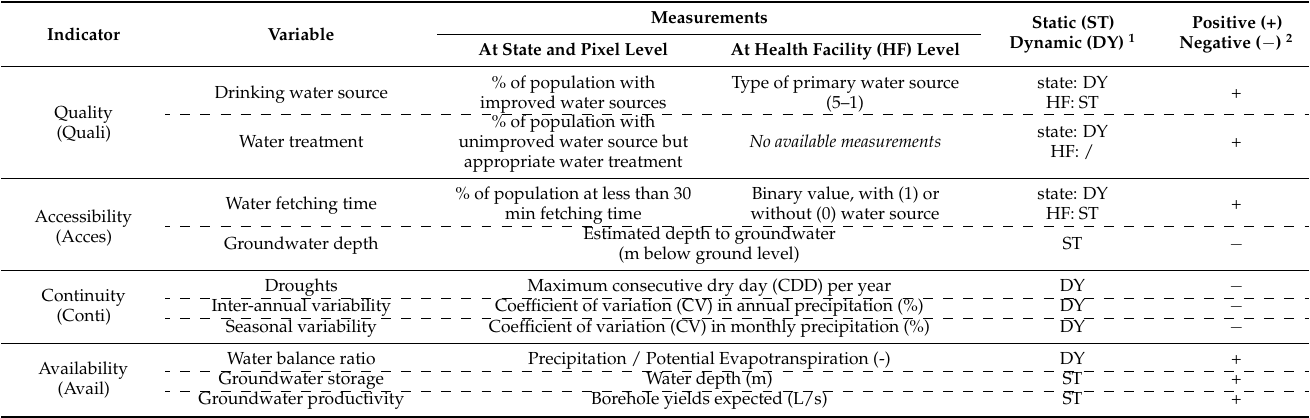
Table 1. Indicators and sub-indicators (variables) of the DWSI with corresponding measurements, units, and characteristics.